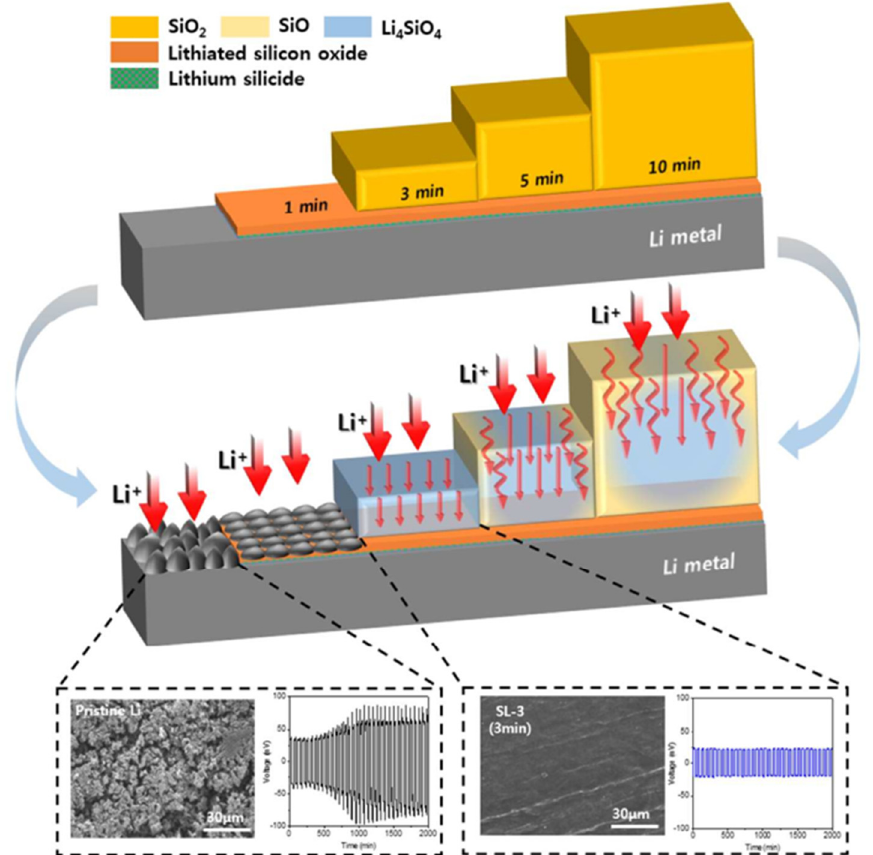
Figure 10. Schematic drawing illustrating the silicon oxide-based passivation layer deposited on the surface of lithium metal anode by the ECR-CVD method. Reproduced with permission from ref.